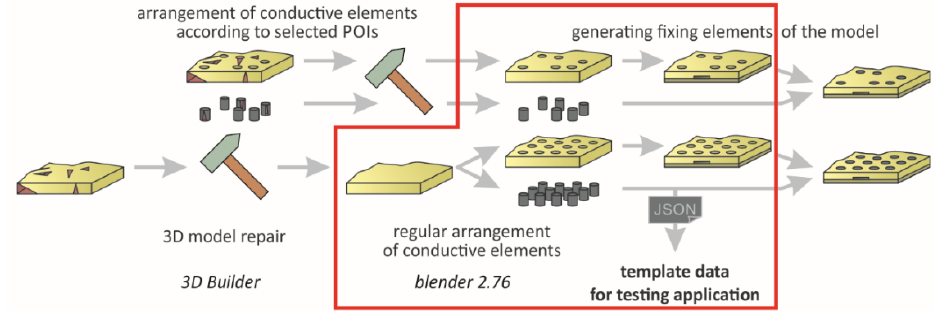
Figure 10. 3D modeling block scheme of the tactile map creation workflow.